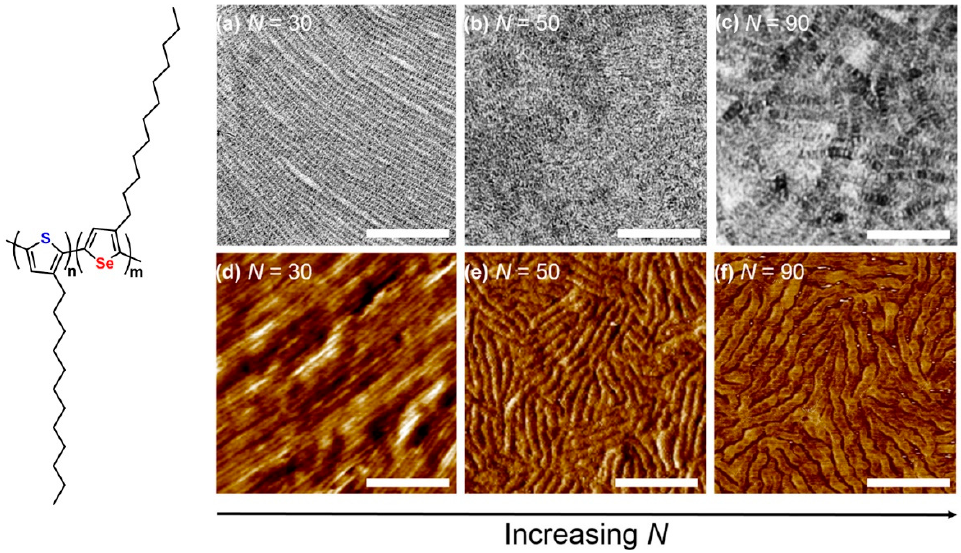
Figure 12. TEM micrographs and tapping-mode AFM phase images of P3DDT- b -P3DDS BCP- annealed thin films depicting lamellar structures (( a , d ), N = 30), co-crystallized fibers (( b , e ), N = 50), and a patchy fiber morphology (( c , f ), N = 90). Scale bars are 200 nm. (Reprinted with permission from Ref. [114]. Copyright American Chemical Society).